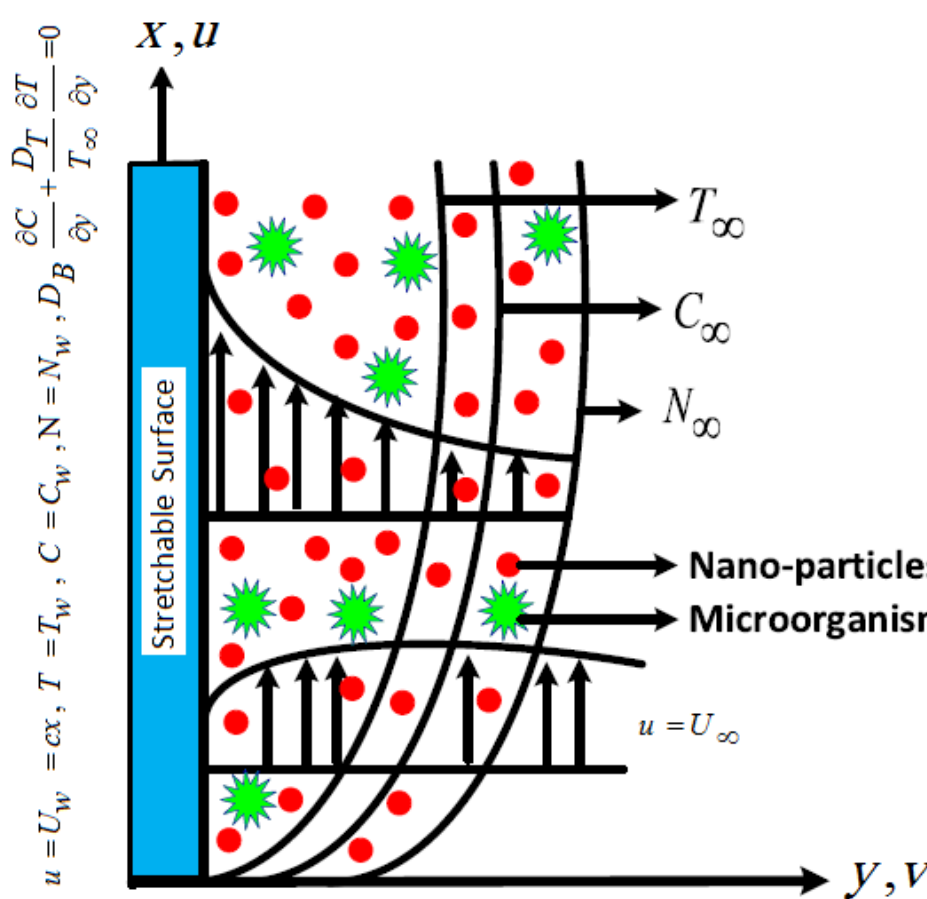
Figure 1. Schematic functionality of the flow.